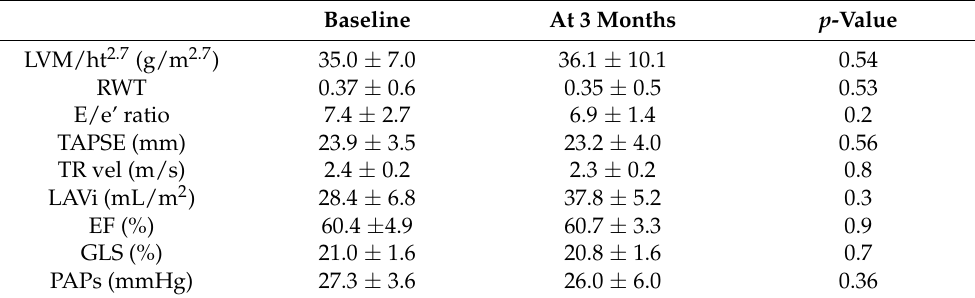
Table 2. Echocardiographic findings at 3 months of treatment with tadalafil. Baseline